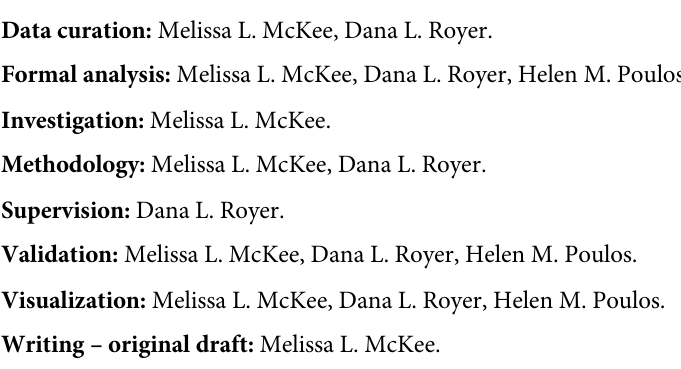
S5 Table. Analysis of variance of a linear model testing for differences in leaf shape in Acer negundo and Carpinus caroliniana across life stage (seedling or sapling), temperature (cool or warm), and the life stage × temperature interaction. S1 Dataset. All leaf physiognomic